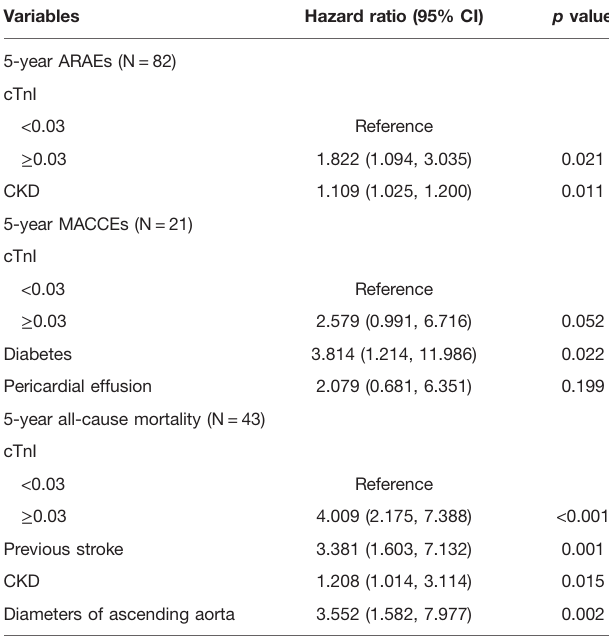
TABLE 4 | Multivariable Cox analyses of the study